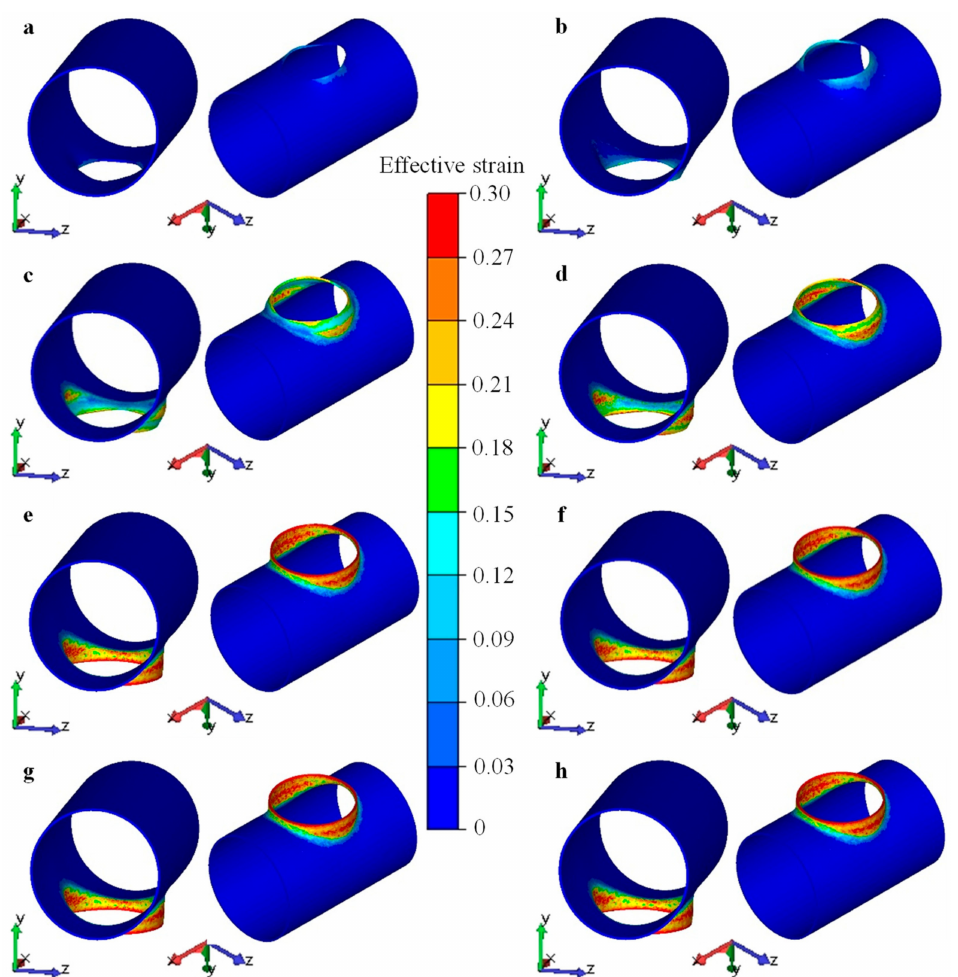
Figure 25. Distribution of strain for workpiece at chosen stages during flanging process, strokes of upper die were ( a ) 100 mm, ( b ) 200 mm, ( c ) 315 mm, ( d ) 350 mm, ( e ) 430 mm, ( f ) 440 mm, ( g ) 475 mm, ( h ) 500